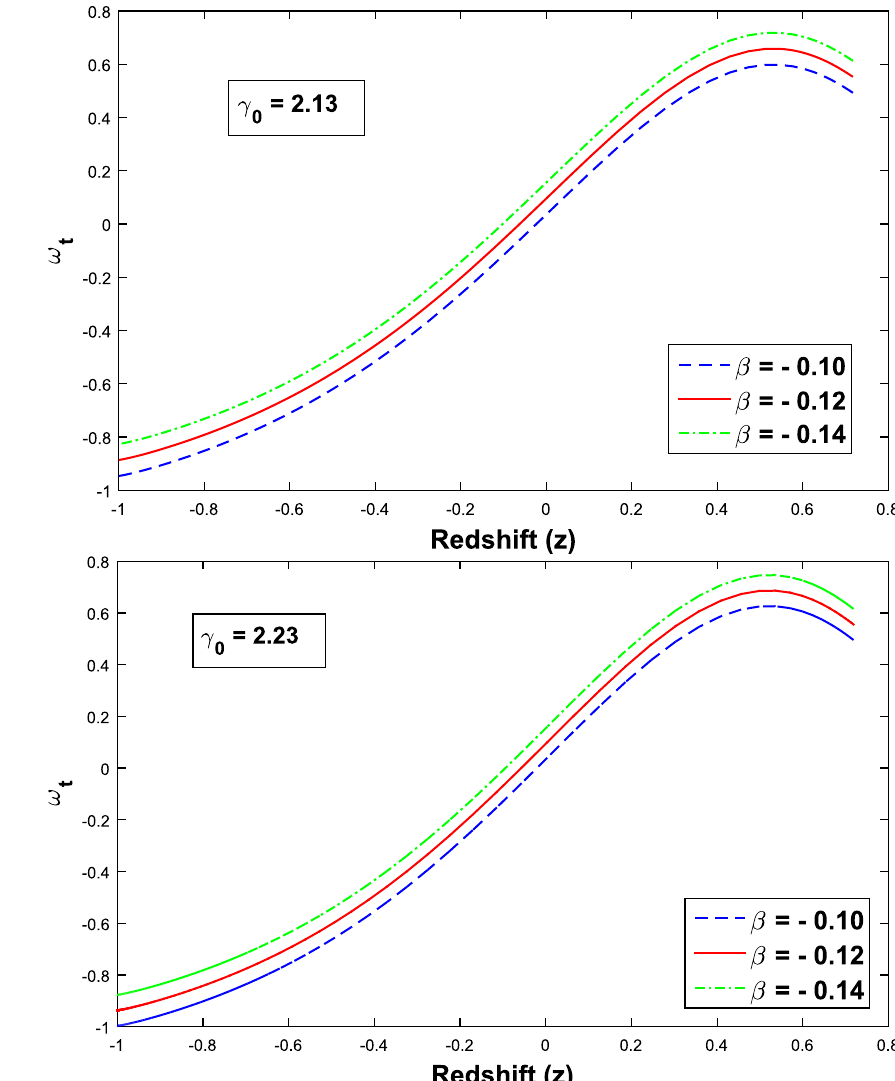
Fig. 7 Plot of EoS parameter of THDE versus redshift ( z ) for c 1 = 0 . 01, c 2 = 0 . 115, k = 0 . 325, γ 0 = 2 . 13, α = 1 . 5, and β = − 0 . 10 , − 0 . 12 , − 0 . 14